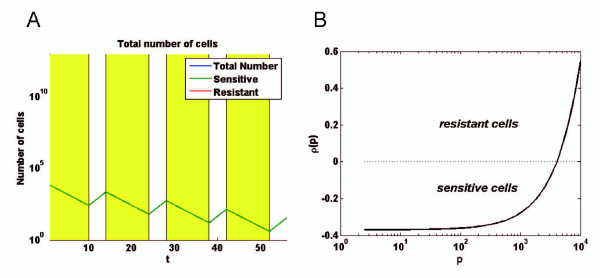
Growth rate of sensitive cell as a function of P-gp content. A, computer simulation giving the number of sensitive MCF-7 versus time during a chemotherapy regimen, cycling every 14 days, with 10 days of 1 μM doxorubicin treatment followed by 4 days of interruption, for 4 cycles. The initial simulated tumour consisted in 104 MCF-7 having growth rates corresponding to ρ(pmin). B, plot giving the growth rates ρ as a function of the P-gp-driven calceinAM efflux activity p for cells exposed to 1 μM doxorubicin. The function describing ρ(p) is used in the simulations presented Figure 8. All cells having a negative growth rate are considered as sensitive MCF-7.